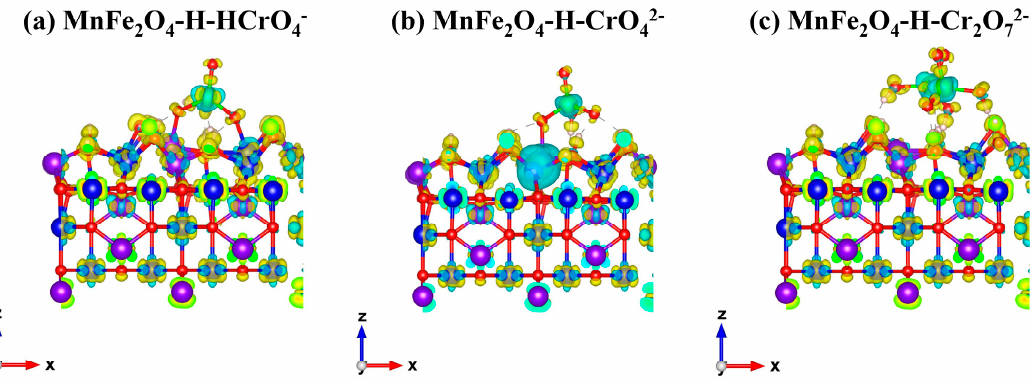
Figure 7. The charge density of MnFe 2 O 4 − H − HcrO 4 − ( a ), MnFe 2 O 4 − H − CrO 42 − , ( b ) and MnFe 2 O 4 − H − Cr 2 O 72 − ( c ).